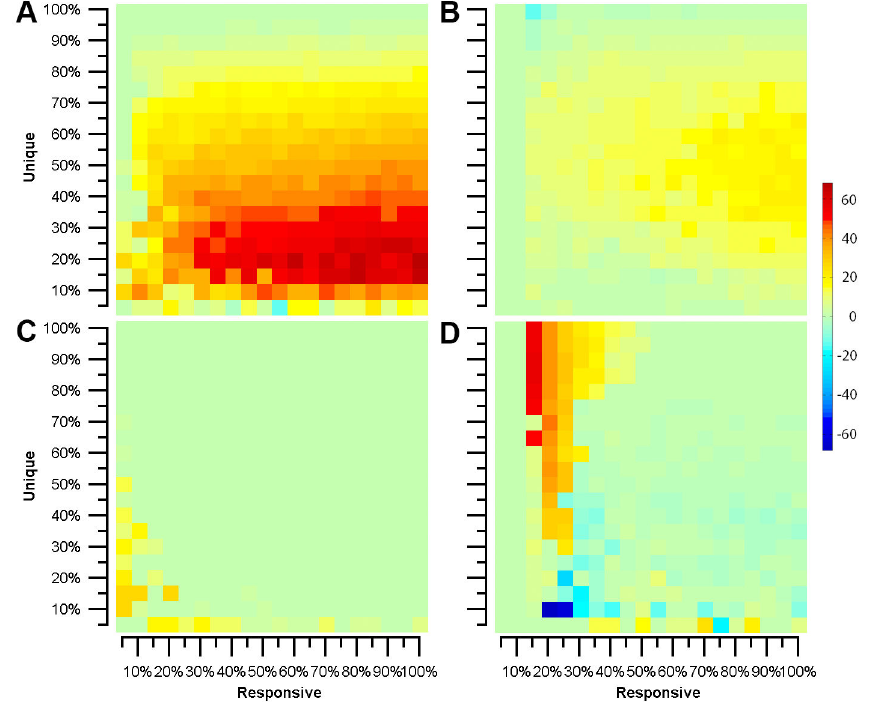
Figure 3. Active learning performance for different model designs. Performance was measured as the difference in the number of batches to achieve (A,B) 100% or (C,D) 90% accuracy between active and random learning. (A,C) Greedy Merge, (B,D) B-Clustering. Warmer colors indicate greater experiment savings with an active